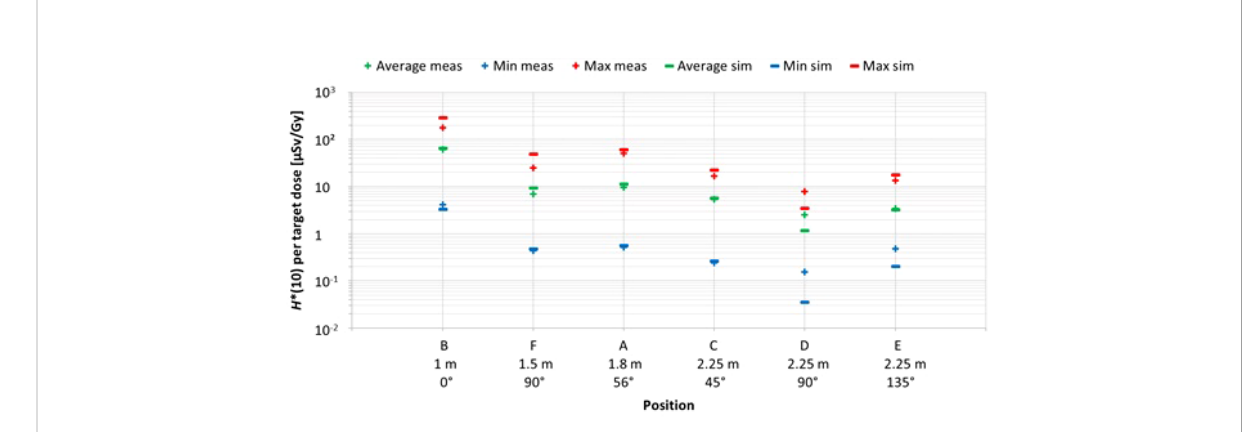
FIGURE 8 Plot of the variation of the simulated H*(10) values (bars) and the measured H*(10) values (crosses) at Skandion as a function of the position. Average (green), minimum (blue), and maximum (red) values are shown. The positions are ordered from left to right according to increasing distance from the isocenter and for same distances according to increasing angle with respect to the proton beam direction.